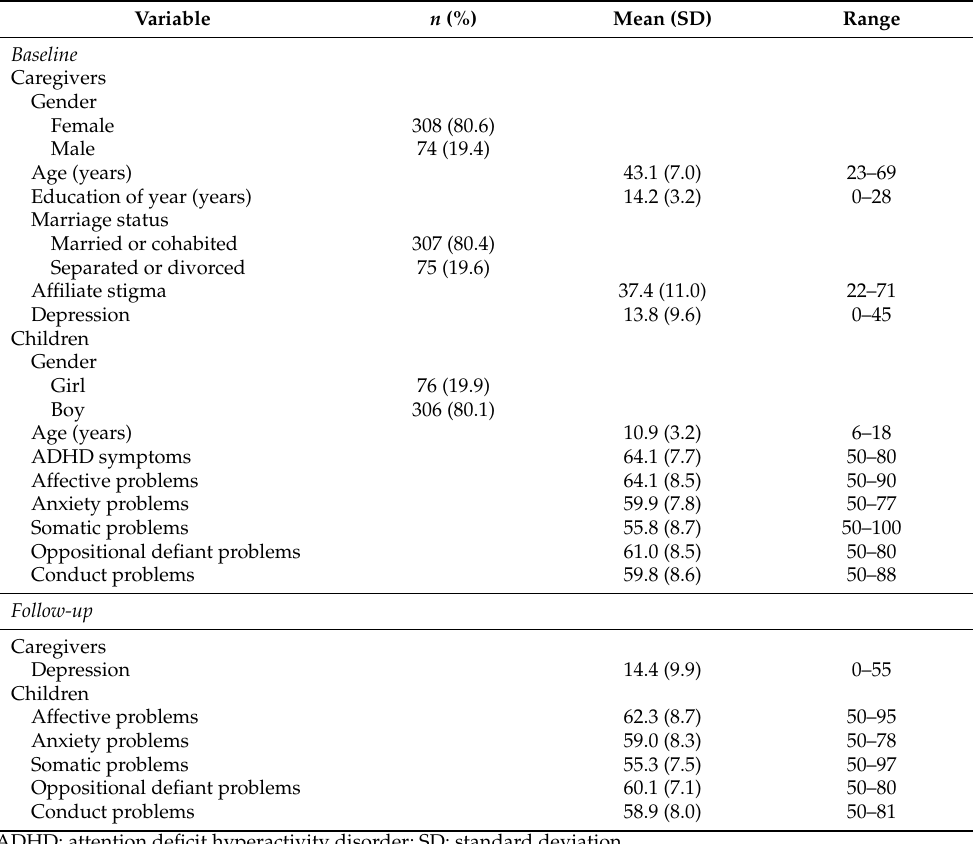
Table 1. Baseline and follow-up data of caregivers and children with ADHD ( N = 382).